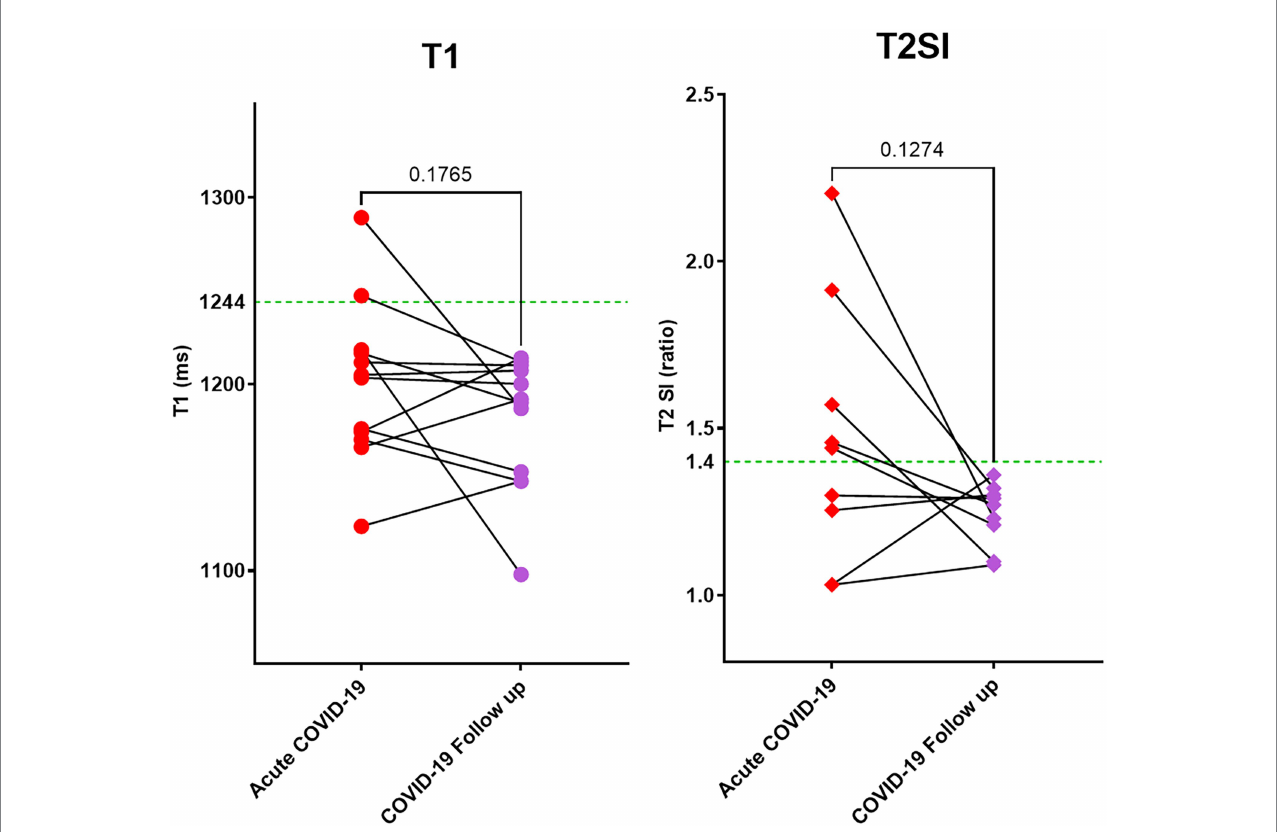
FIGURE 3 Myocardial tissue characteristics as measured by CMR T1 mapping and T2 weighted imaging. During acute COVID-19 illness and at follow up (at 6 months). Out of 23 patients scanned during acute COVID-19, 12 returned for follow up during the pandemic. All patients had normal T1 and T2SI ratio at follow up. Green dotted line in the graphs denote the upper limit of normal range for T1 and T2SI ratio in the 3 T MR scanner used for this study.